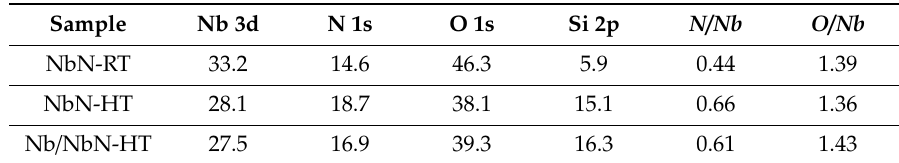
Figure 5. XPS survey spectra results of different coatings deposited on Si wafers. Table 4. XPS relative surface chemical composition of the coatings, expressed as an atomic percentage